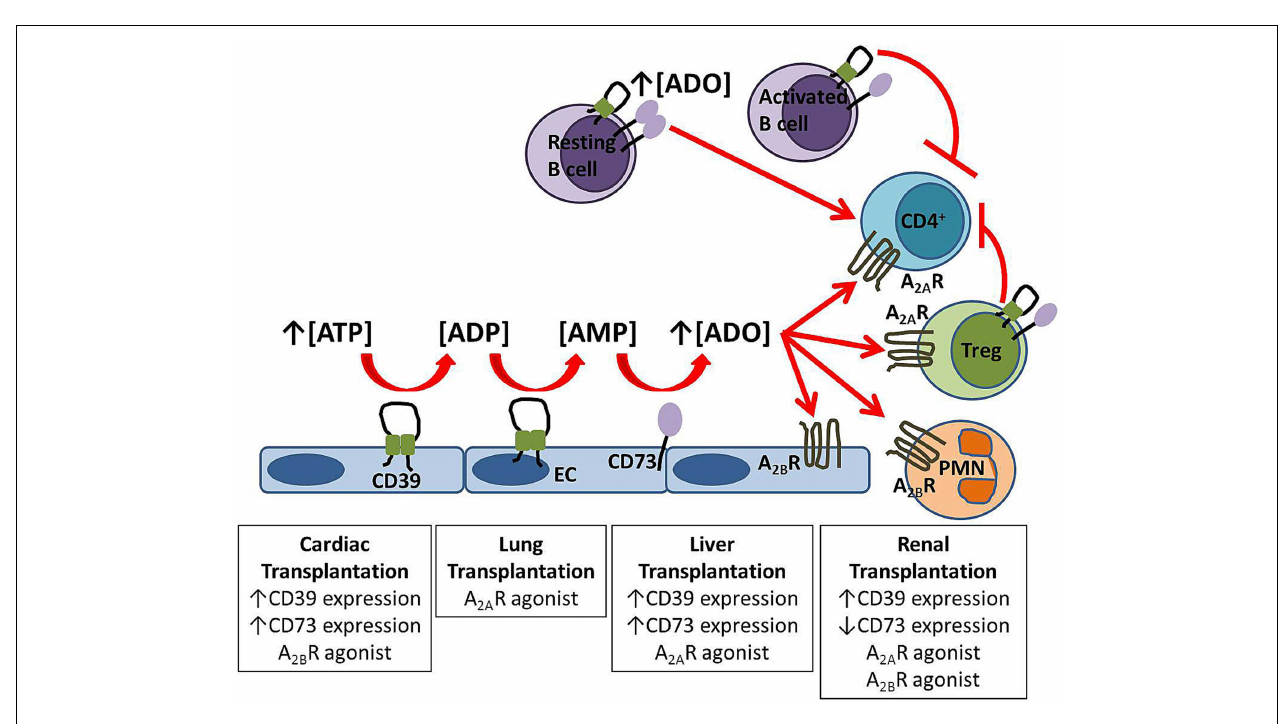
circulating cells including regulatoryT cells (Treg) and via A 2B R expressed both on the vasculature and inflammatory cells. Experimental strategies which improve graft outcome for each solid organ transplant are listed in